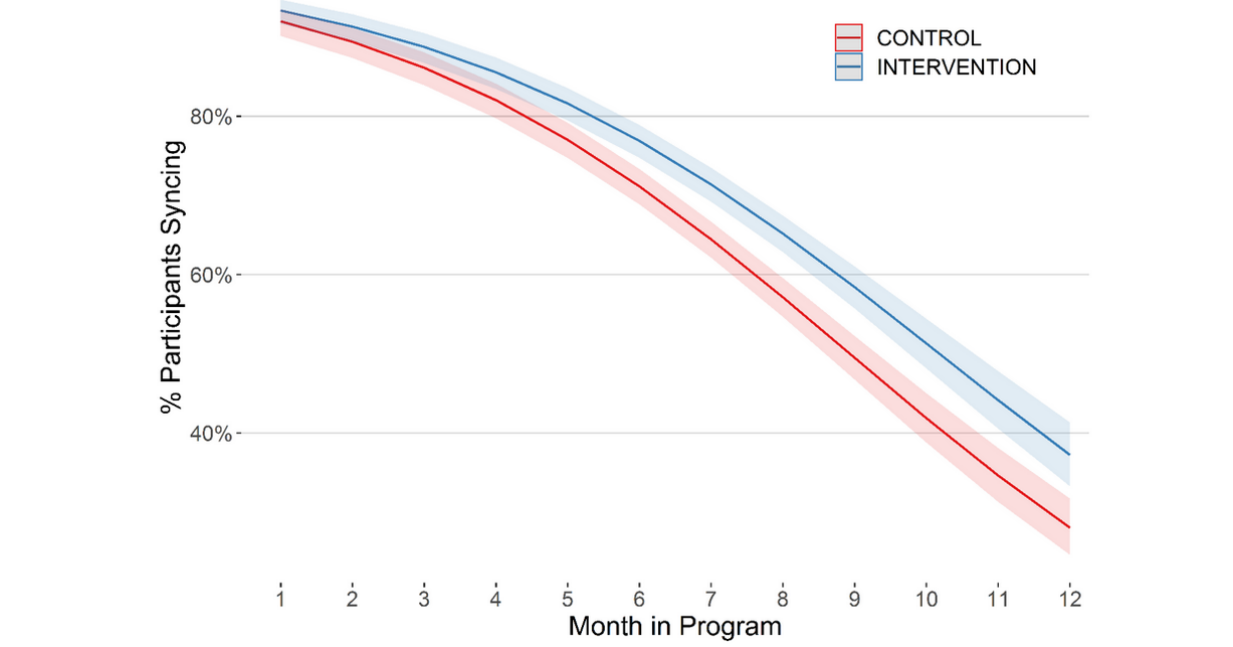
Figure 2. Percentage of participants who synced their Fitbit within the last 30 days by month and